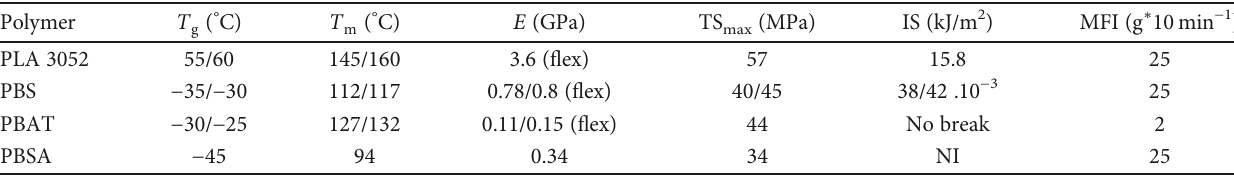
Table 3: Properties as speci fi ed by the manufacturers. Glass transition temperature ( T ), and impact strength (IS). NI (not indicated by the manufacturer). Courtesy of the maximum load (TS max